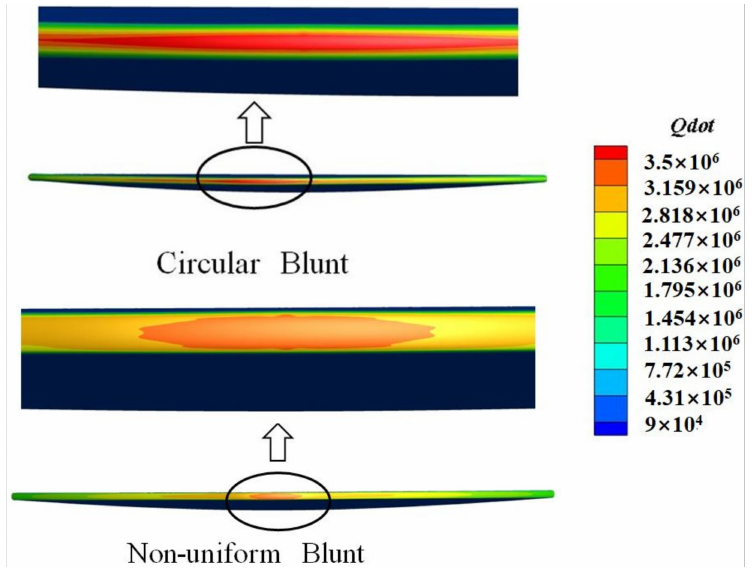
Figure 11. Heat flux distribution of two blunt profiles (diameter/height: 4 mm, angle of attack: 0 degrees, units: w/m 2 ).